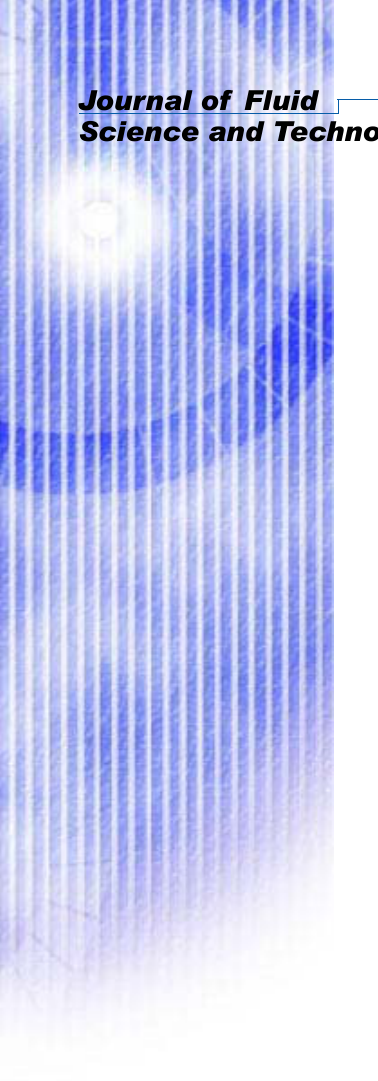
Fig.1 Experimental arrangement and definitions of symbols.